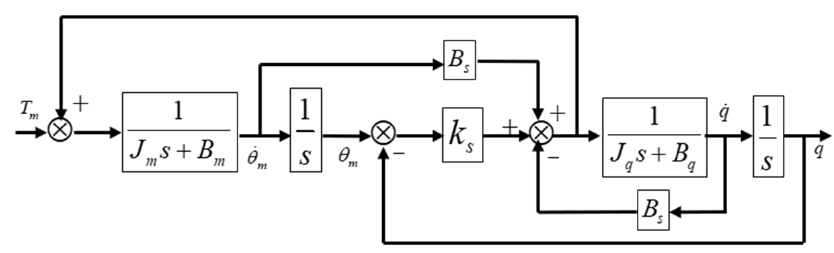
Figure 2. Block diagram of virtual flexible joint control system.